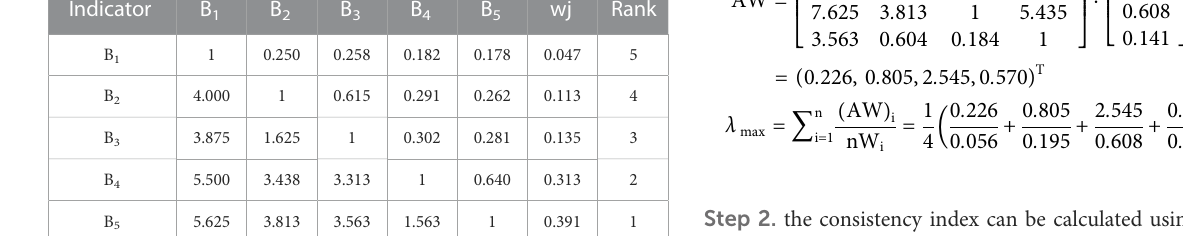
TABLE 17 Pairwise comparison matrix of civil construction factor layer (AHP). Indicator